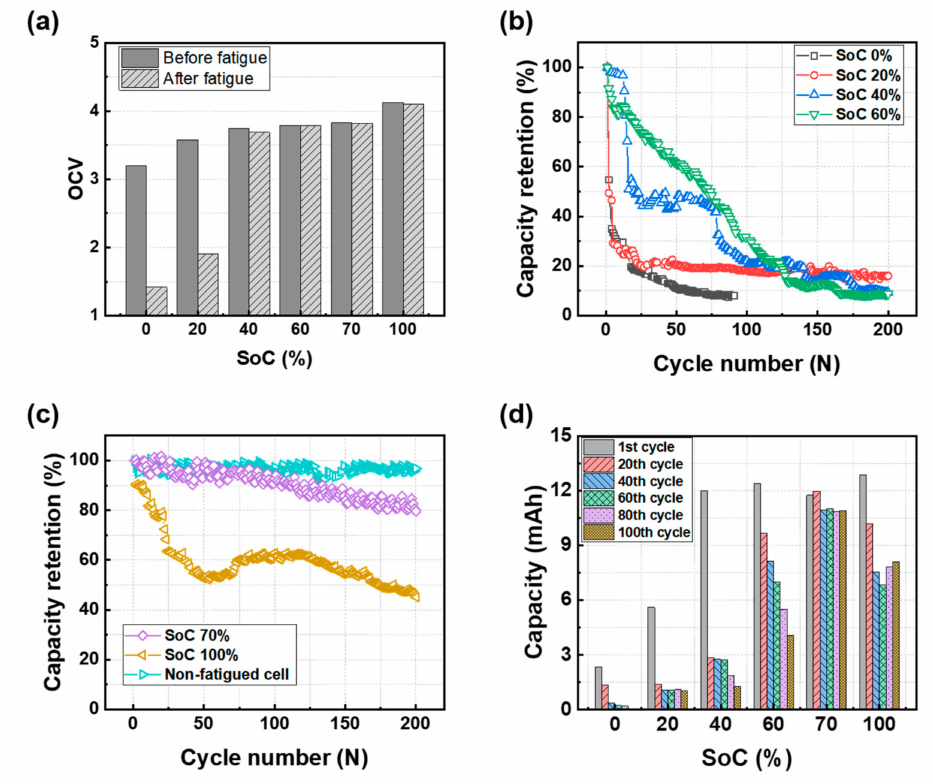
Figure 4. ( a ) OCV and ( b , c ) cycling performance of the pouch-type batteries after the mechanical fatigue test (torsion test at 10 ◦ , 100,000 cycles) with different initial SoCs; ( d ) the capacity after various cycles under different initial SoC